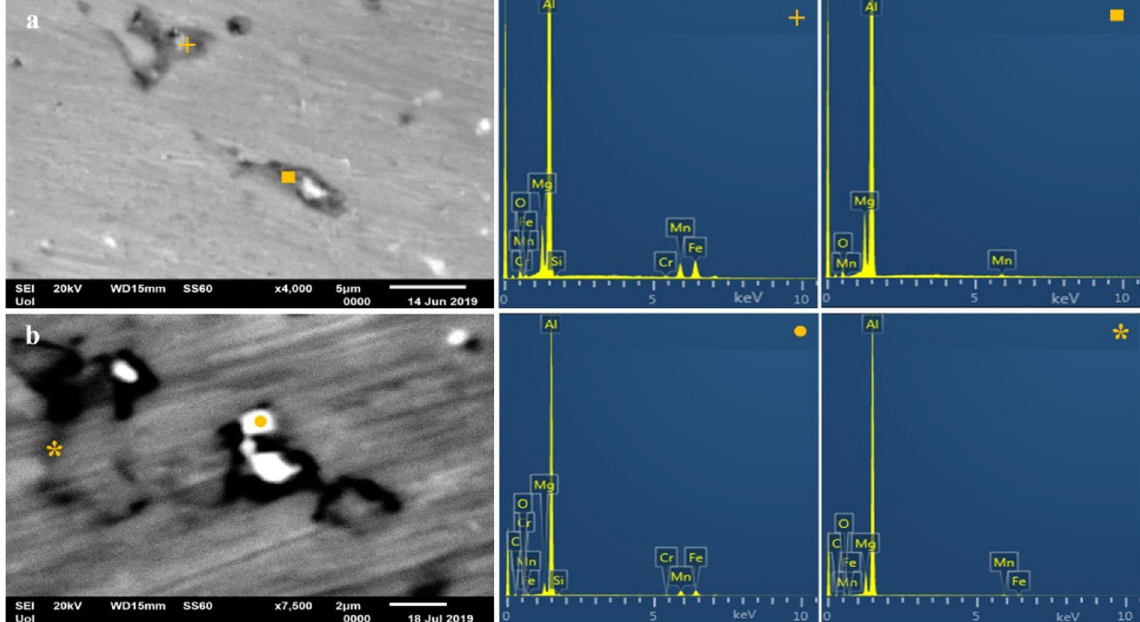
Fig. 8 Cross-sectional micrographs after corrosion testing. a Interlayer boundaries (zone c) showing preferential corrosion of the Al-Mg matrix (sp. ▪ ) around Al-Fe-Mn-Cr-Si (sp. + ) particles; b Within an overlayer (zone d) showing preferential corrosion of the Al-Mg matrix around Al-Fe-Mn-Si-Cr precipitates (sp. (cid:129) ) and IGC associated with the intergranular presence of Fe (sp.*). npj Materials Degradation (2021) 26 Published in partnership with CSCP and